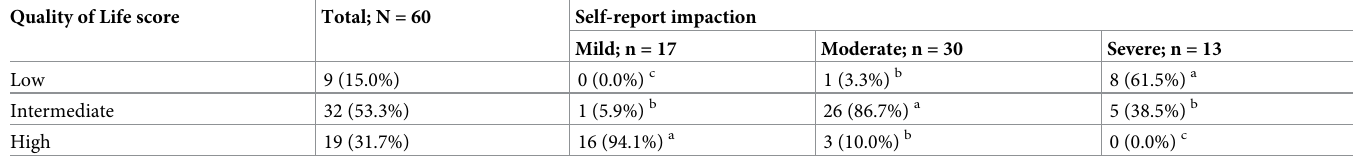
Table 4. Cross tabulation between quality of life in patients with anal fistula questionnaire (QoLAF-Q) scores and quality of life self-reports of patients with anal fistula. Quality of Life